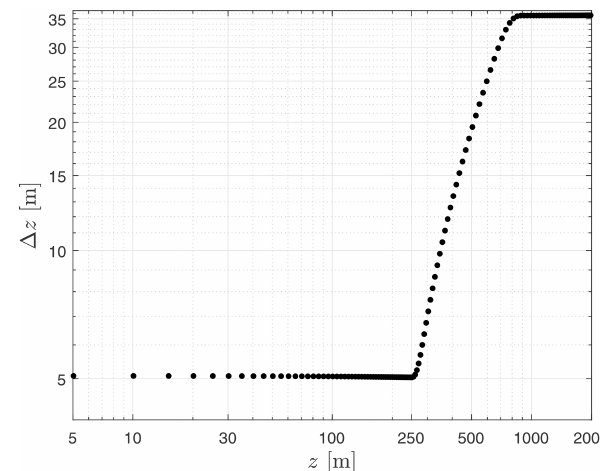
Figure 2. Vertical grid spacing as function of vertical level used in the simulations. The vertical level corresponds to the cell height.